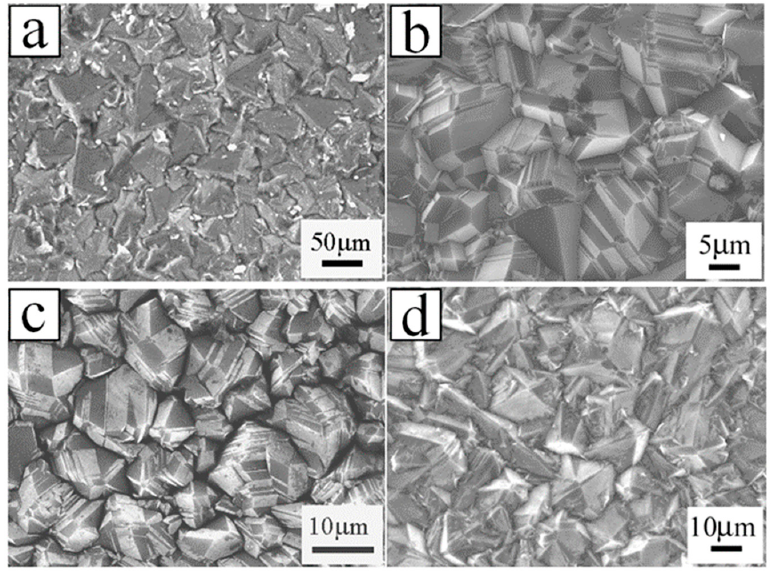
Figure 3. SEM images of the boron-doped diamond (BDD) with plane view grown with the boron of ( a ) 2 sccm, ( b ) 2 sccm, ( c ) 10 sccm and ( d ) 20 sccm [62].